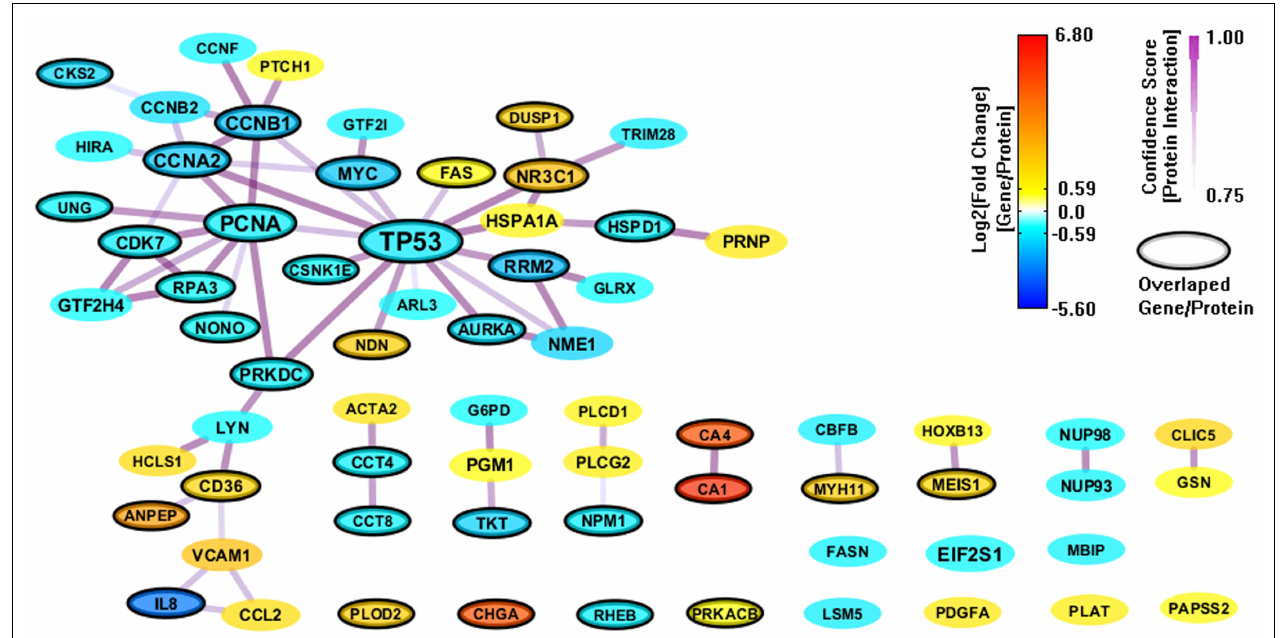
represent differential gene expressions, node size represents the local topological property, edge color and edge width represents confidence score for each protein interaction. Black-circled genes represent the enriched genes from both MSigDB and